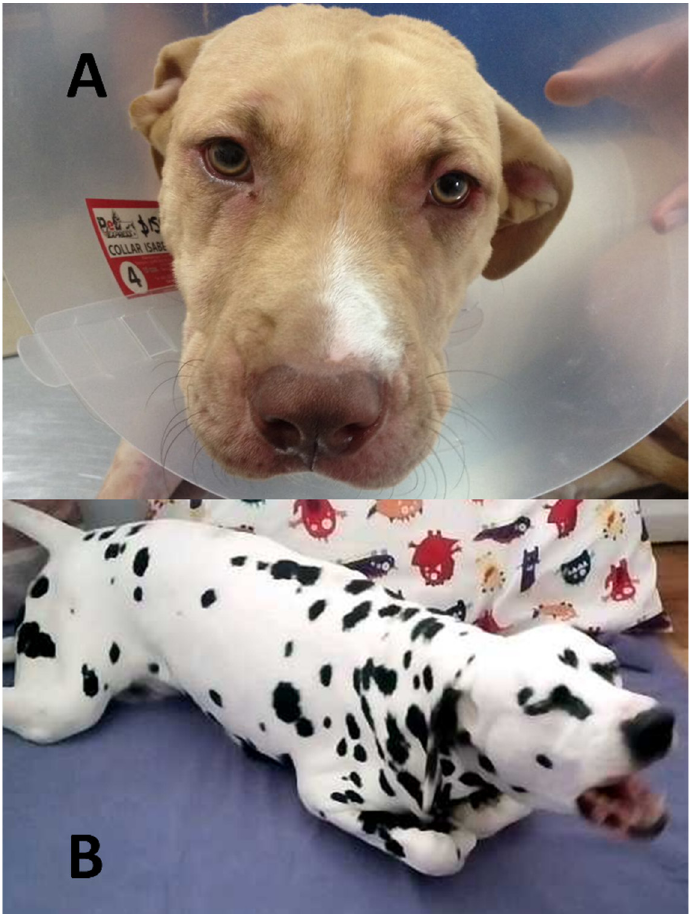
Figure 10. Expressions related to pain. ( A ). Mild pain. Expressions are characterized by a sustained raising of the eyebrows with displays of the frontal region of the head and lateral abduction of the ears, generally associated with a sad face, as represented in this image of a one-year-old female Pitbull, which shows a slight anaphylactic reaction. ( B ). Severe pain. Expressions are characterized by semi-closed eyelids, cheek tension, and vocalizations, as can be seen in the image of this two-year-old female Dalmatian with acute polyradiculoneuritis.